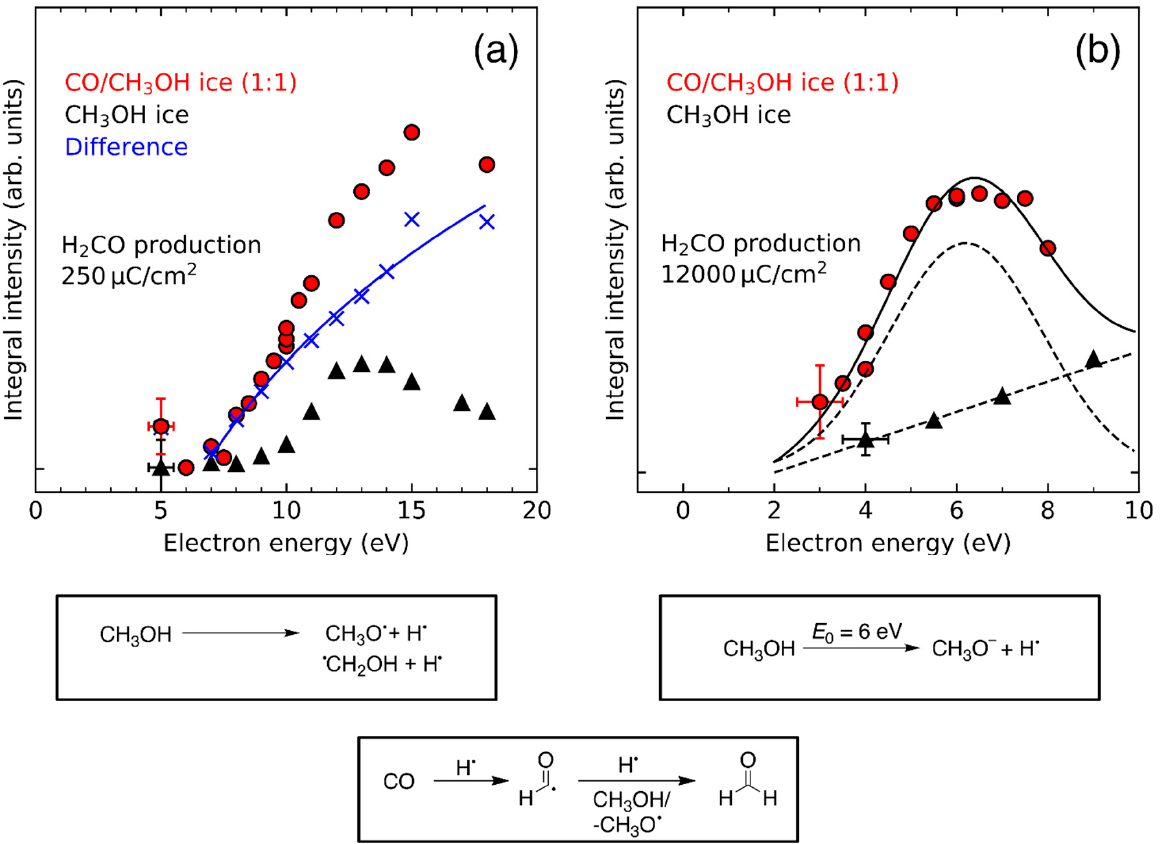
Figure 11. Dependence of the integrated desorption signal of H 2 CO on electron energy ob- tained by TDS after irradiation of pure CH 3 OH ( (cid:78) ), and CO/CH 3 OH (1:1) mixed ices ( • ) with ( a ) 250 µ C/cm 2 and ( b ) 12,000 µ C/cm 2 . At lower electron energies, higher exposures can be used as product degradation is negligible. This enhances the detection of products with smaller yields. The difference curve ( × ) in panel ( a ) is reflective of an additional reaction channel that is not accessible in pure CH 3 OH. The reaction schemes (bottom) denote the processes that lead to the enhanced production rate of H 2 CO in CO/CH 3 OH mixed ices. The solid and broken lines serve as a guide to the eye. Adapted from Ref. [31] with permission from the PCCP Owner